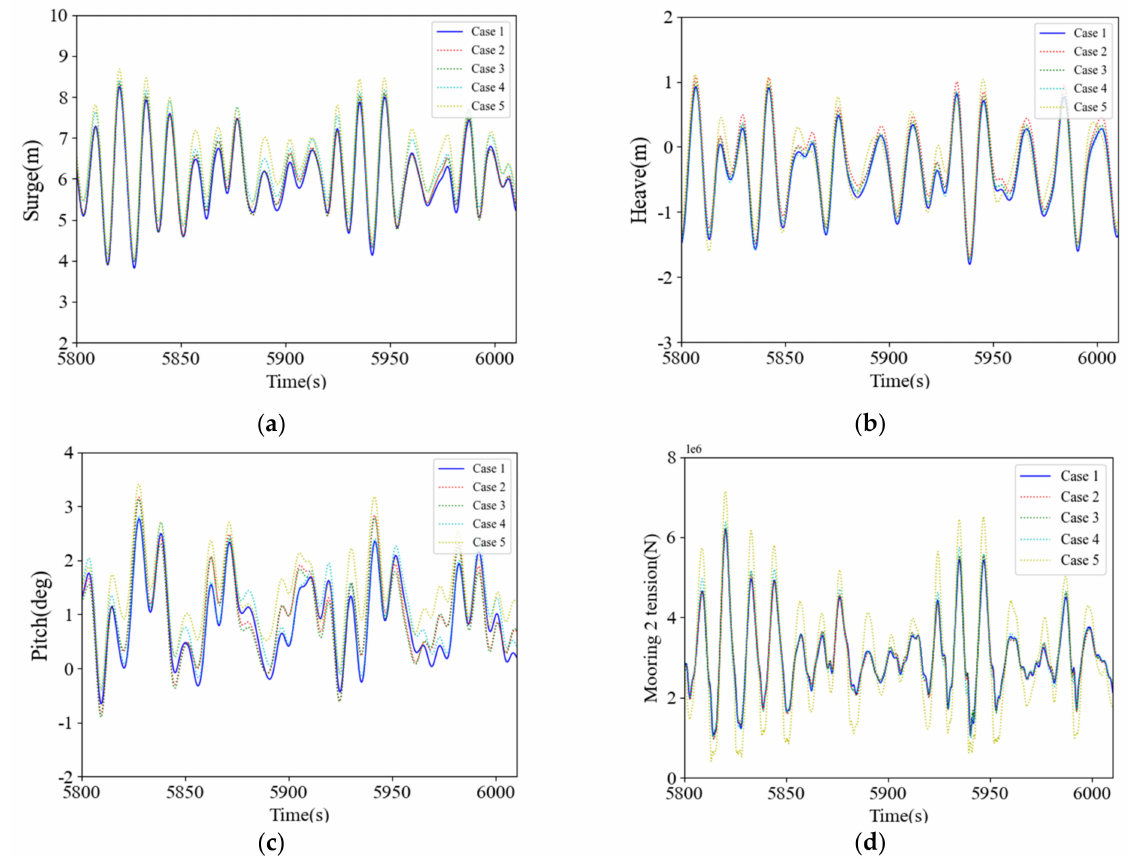
Figure 10. Comparison diagram of time history curve of floating wind turbine with different parame- ter and fitting combination. ( a ) Surge. ( b ) Heave. ( c ) Pitch. ( d )